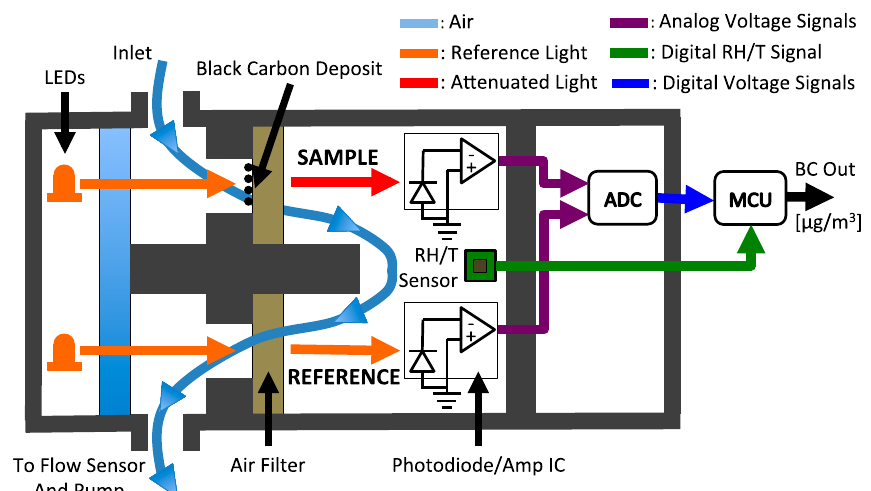
Figure 2. Functional diagram of the ABCD optical cell.